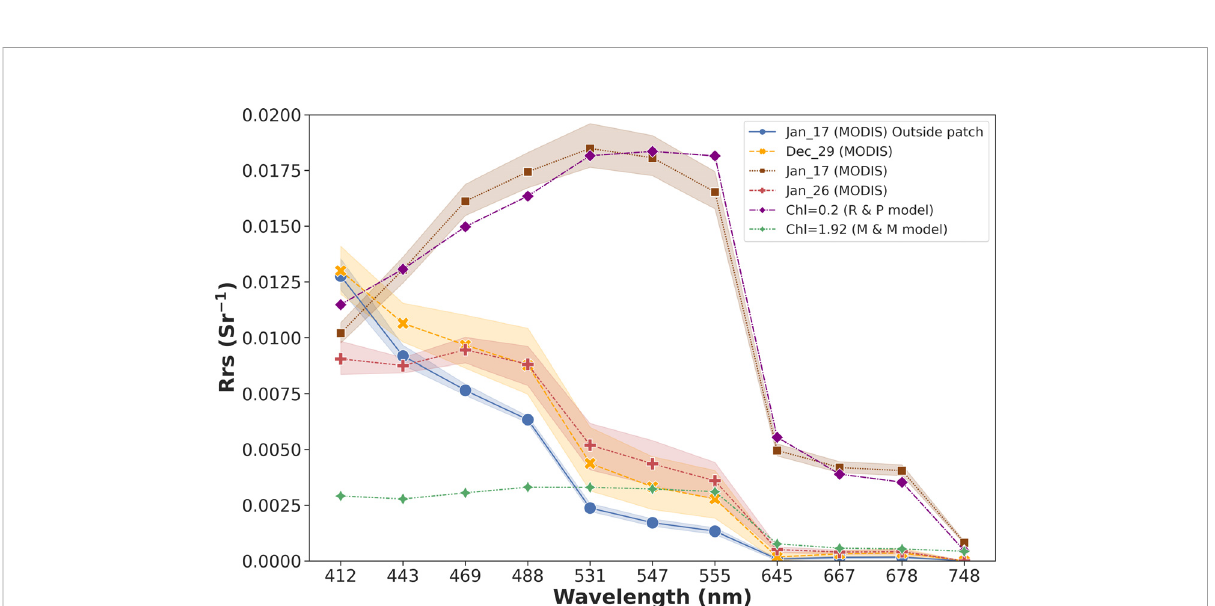
FIGURE 3 Rrs spectra of pixels inside the discolored water patch and outside the patch pre- and post-eruption (December 29, 2021; 2 days after the eruption on January 17, 2022; 9 days after the eruption on January 26, 2022) and another on 17 January if Chl=0.2 mg.m -3 using the Park and Ruddick (2005) model, and Chl=1.92 mg.m -3 using the Morel & Maritorena (2001) model. Pixels outside the patch were taken on 17 January